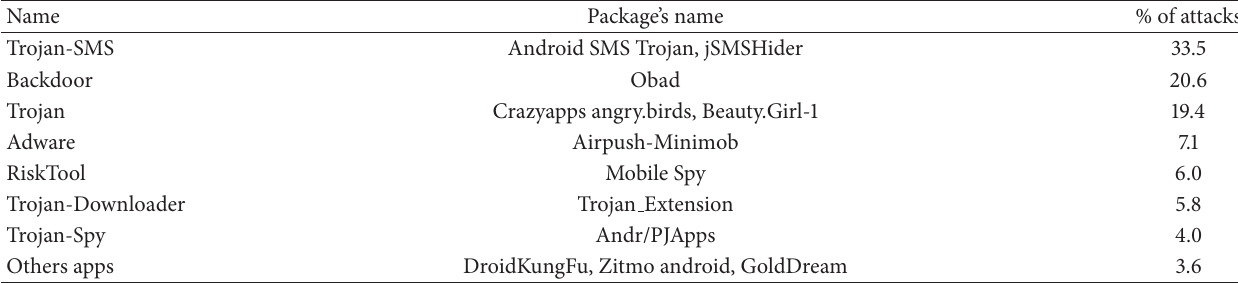
Table 5: Mobile malware for this research.